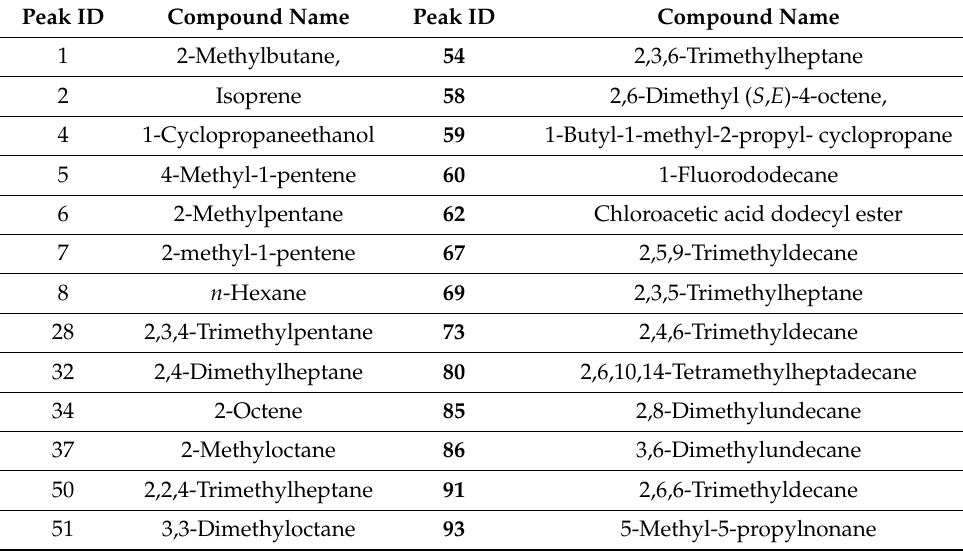
Table 3. Summary of the chemical names, IDs, and retention time of all the